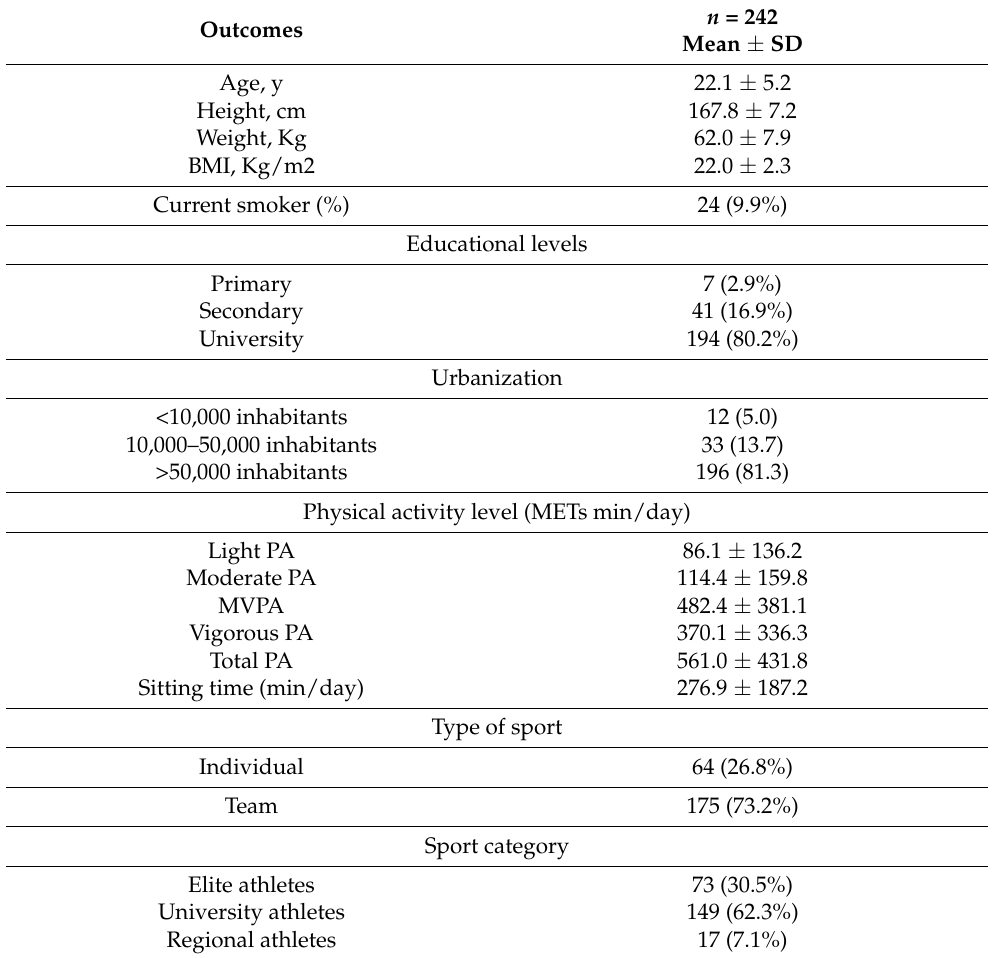
Table 1. Descriptive characteristics of the study